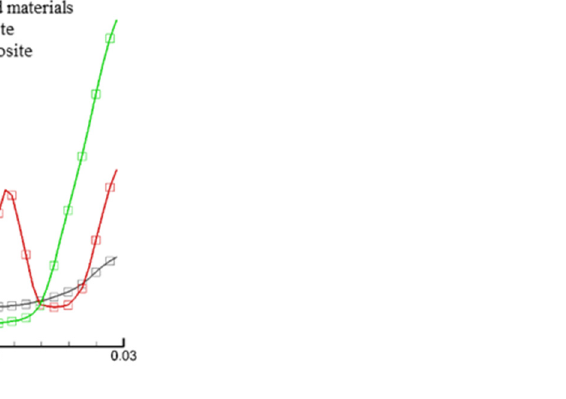
Figure 17. Residual maximum principal stress along the monitoring line in composite material and FGMs.